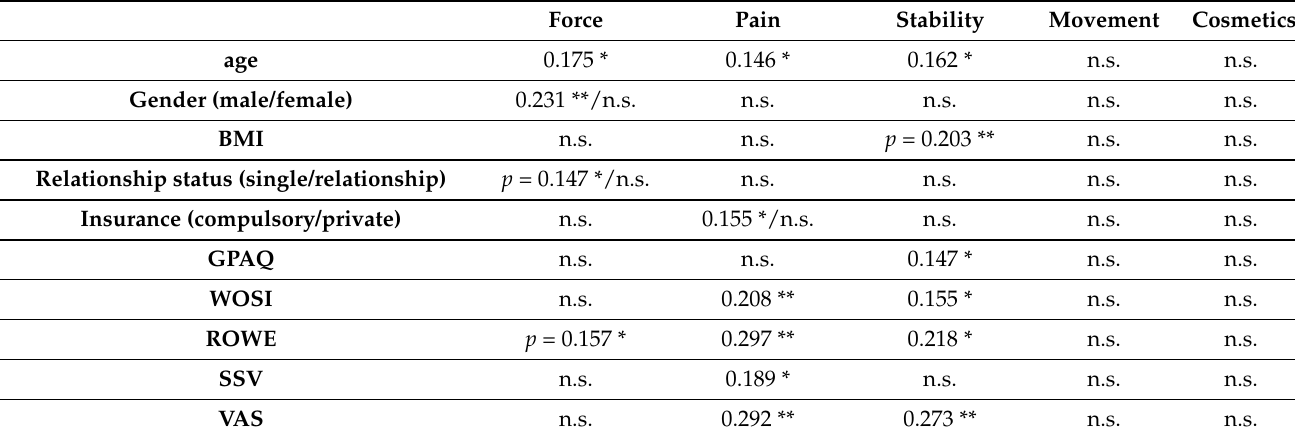
Gender (male/female) 0.231 **/n.s.